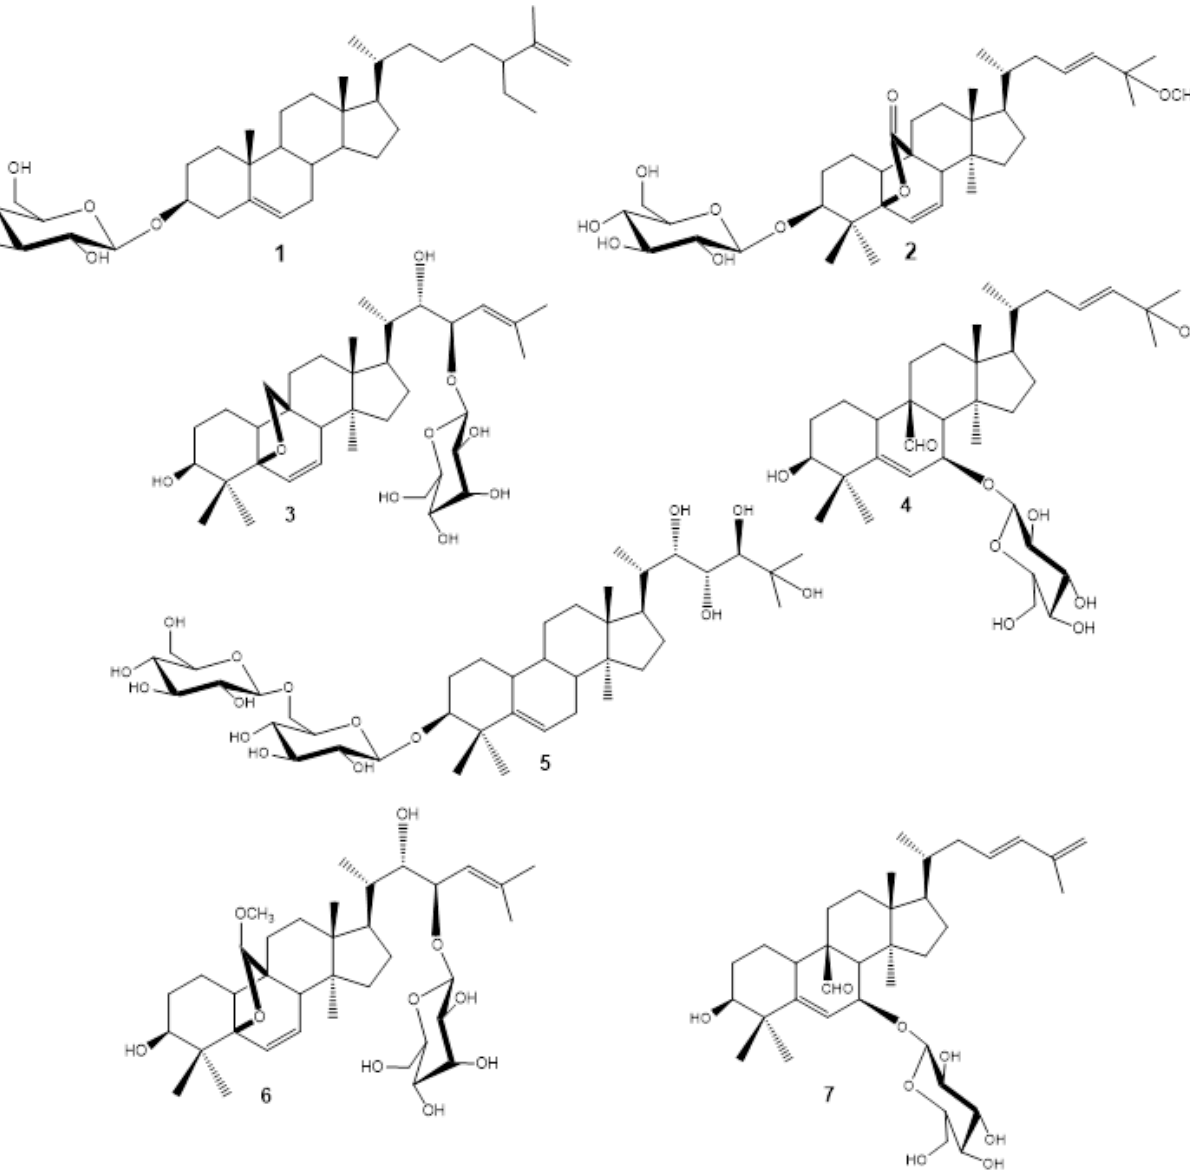
Figure 2. Chemical structures of compounds isolated and identified in the present study. ( 1 ) 25 ξ -isopropenylchole- 5(6)-ene-3- O - β - D -glucopyranoside, ( 2 ) karaviloside VI, ( 3 ) karaviloside VIII, ( 4 ) momordicoside L, ( 5 ) momordicoside A, ( 6 ) charantoside XV, and ( 7 ) kuguaglycoside